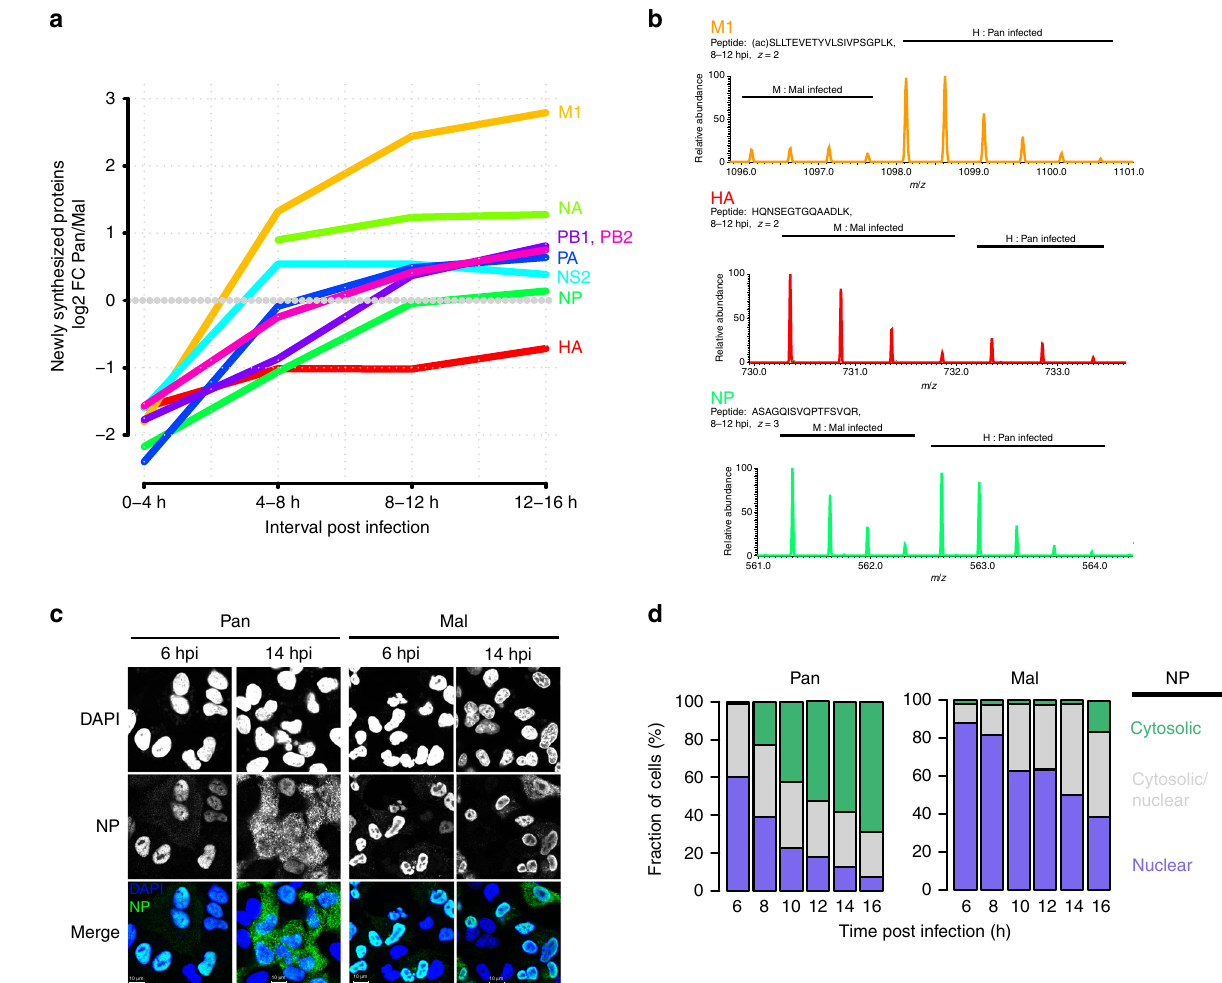
Fig. 3 Viral protein synthesis is dysregulated during non-permissive infection. a SILAC protein synthesis pro fi les of human vs. avian-adapted IAV proteins based on shared peptides. No shared peptides were identi fi ed for NS1 and M2. The average of n = 2 biological replicates is shown. b MS1 spectra of individual precursor (M1 — top, HA — middle, NP — lower) peptides in M and H SILAC channels. c Cells were infected with the indicated viruses at MOI = 1 (FFU/cell) and analyzed by immuno fl uorescence microscopy for NP traf fi cking. Nuclei were counterstained with DAPI. Scale bars: 10 µ m. d For quanti fi cation, NP staining pattern was categorized as predominantly cytosolic, nuclear or both. At least 140 cells were counted per